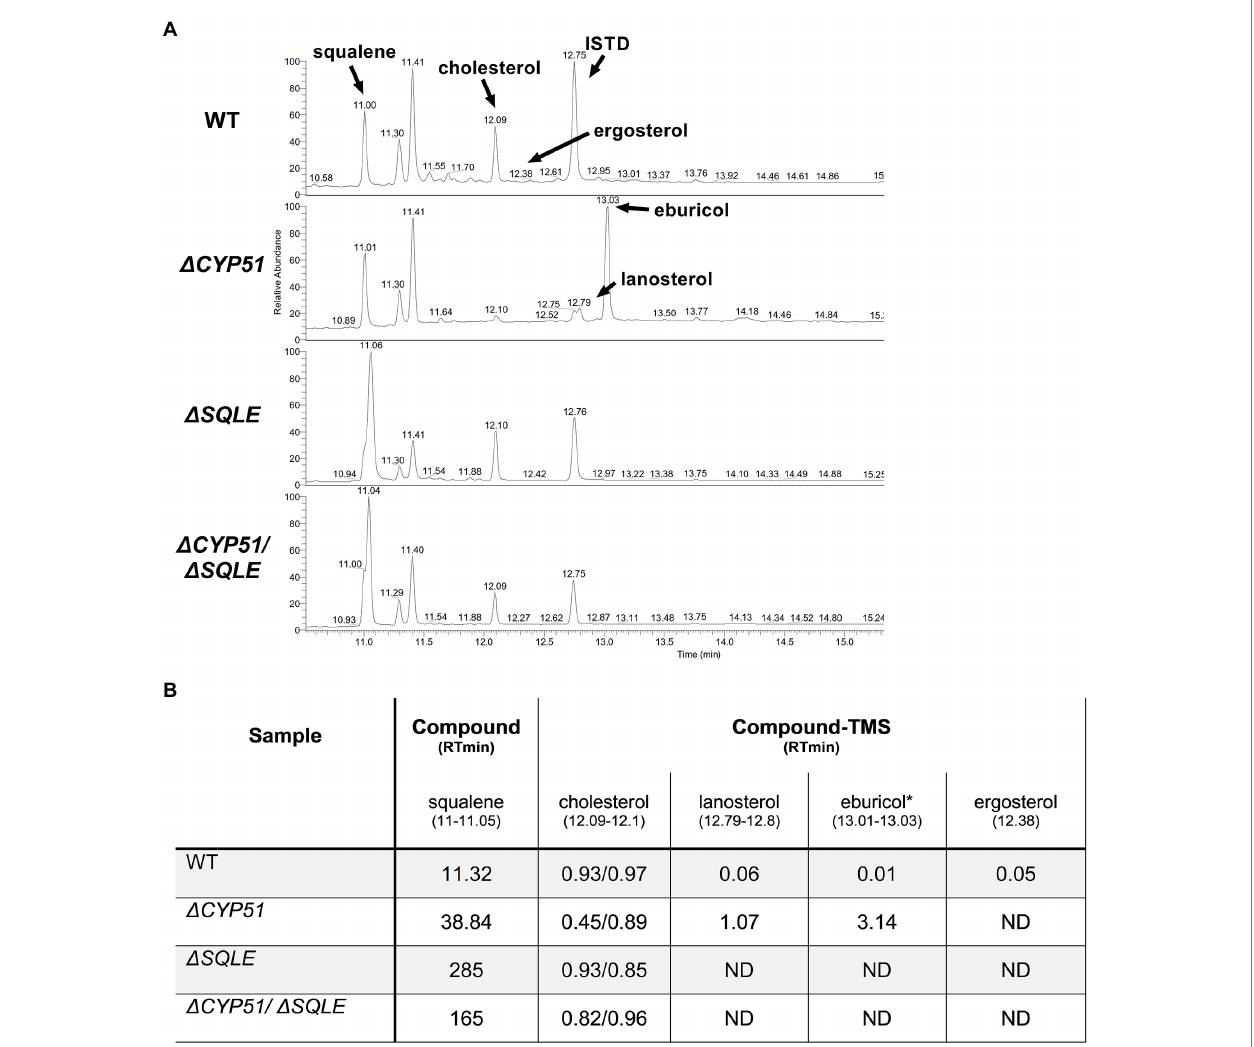
FIGURE 6 | (A) GC–MS chromatogram derived from lipid extractions from the indicated parasite lines. The internal standard (ISTD) along with endogenous and exogenously derived sterols are indicated along with squalene. (B) Table of detectable sterol species and retention times from panel A and their relative signal compared to the ISTD. Each sample was split and half underwent saponification (2 h at 68 ° C in 1 M methanolic potassium hydroxide) to cleave cholesterol esters. ISTD normalized values are shown for cholesterol with and without saponification (free sterols/post saponification). Species were identified using a chemical standard unless indicated by an asterisk (*). ND = not